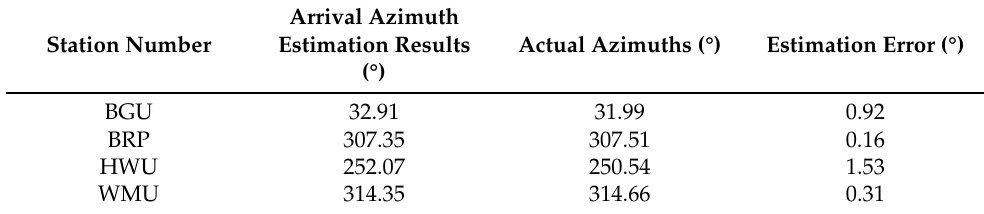
Table 3. Arrival azimuth estimation error of the SBL algorithm for four